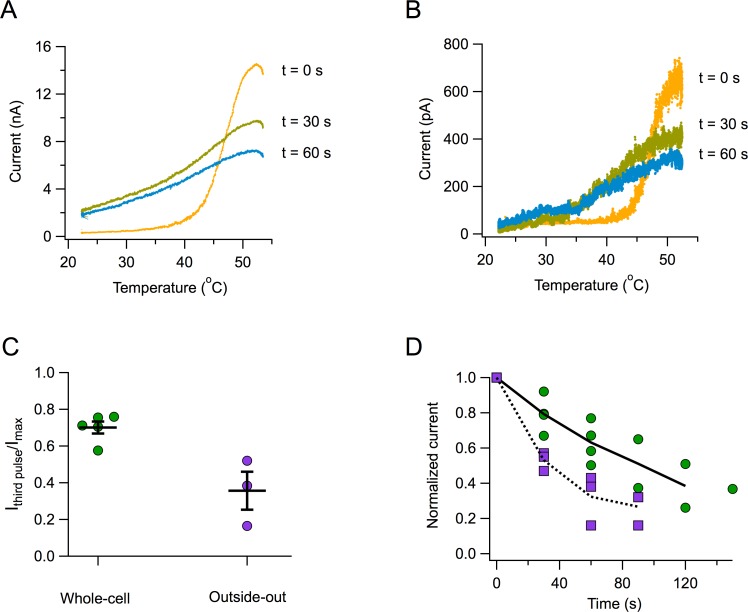
Current loss with repetitive stimulation is observed in whole-cell and outside-out recordings.(A) Whole-cell recoding forms a HEK293 cell. Inactivation of the current is obvious, as is the reduced steepness of the response to a second and third temperature ramp. Interval between ramps is 30 s. (B) Temperature-activated TRPV1 currents recorded in the outside-out configuration. As is the case in whole-cell and inside-out recordings, current loss remains to be present with consecutive activations. Interval between ramps is 30 s. (C) Fractional reduction of current between the first and third activation ramp, for whole-cell and outside-out recordings. (D) Time course of current decay for cells in whole–cell recording mode (green circles, n = 4) and outside-out mode (purple squares, n = 3). The continuous and dotted black curves are the mean for whole-cell and outside-out, respectively. Maximum ramp temperature was 53.2°C.